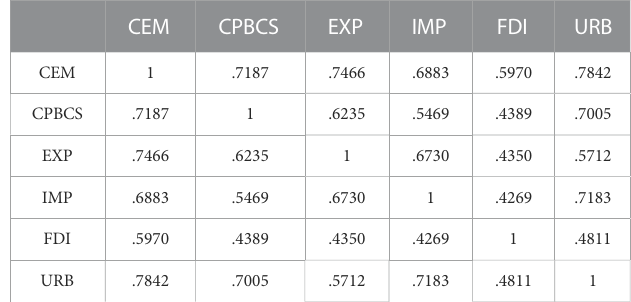
TABLE 2 Correlation between